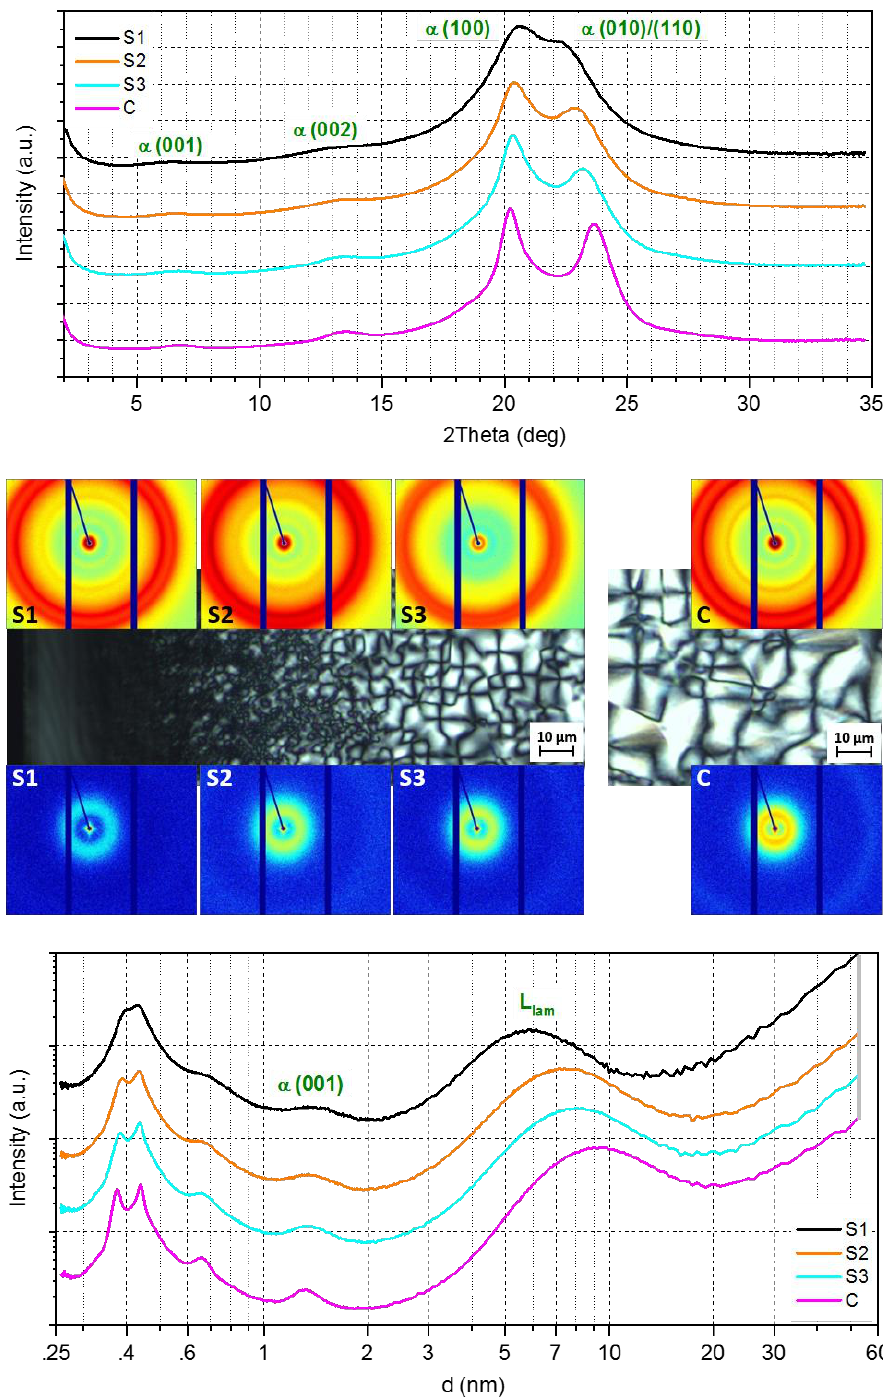
Figure 4. X-ray analysis from skin to core. 2D-Wide-angle X-ray scattering (WAXS) above and 2D-small-angle X-ray scattering (SAXS) patterns below the POM micrographs in the middle. WAXS and SAXS patterns were taken at the sample positions as visualized inside the POM micrographs. Radial intensity graphs 1D-WAXS (above: I vs. 2 θ ) and 1D-WAXS / SAXS (below: lg I vs. lg d), azimuthally integrated from 2D-WAXS and 2D-SAXS patterns (curves are shifted vertically). Scattering area coordinates: 2D-WAXS – q x : − 16.8–20.0 nm − 1 , q y : − 17.5–13.0 nm − 1 , and 2D-SAXS – q x : − 4.19–5.34 nm − 1 , and q − 4.31–3.14 nm − 1 y :